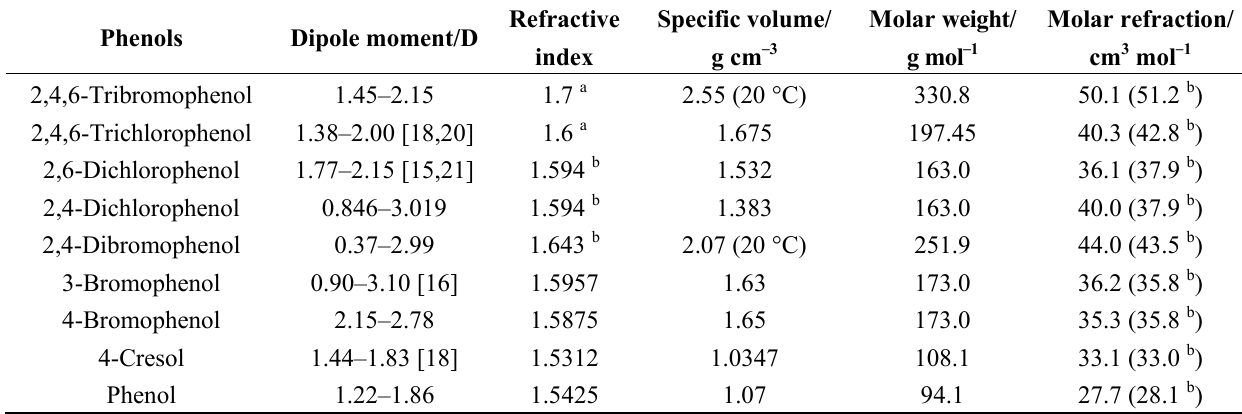
Table 3. Calculation of molar refraction for